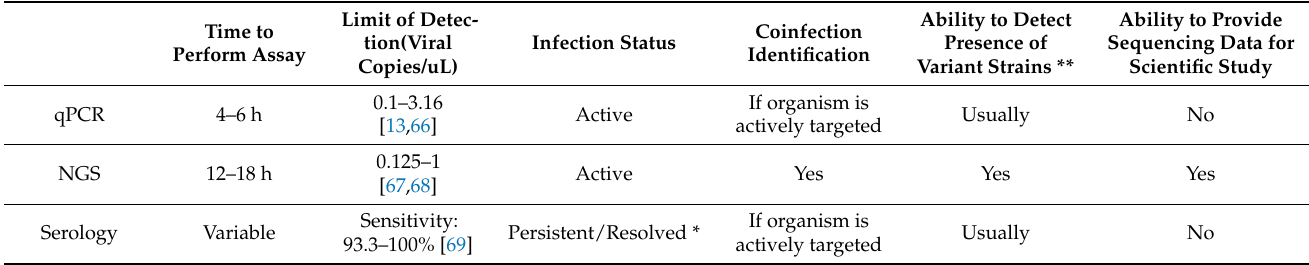
Table 3. Comparison of common testing